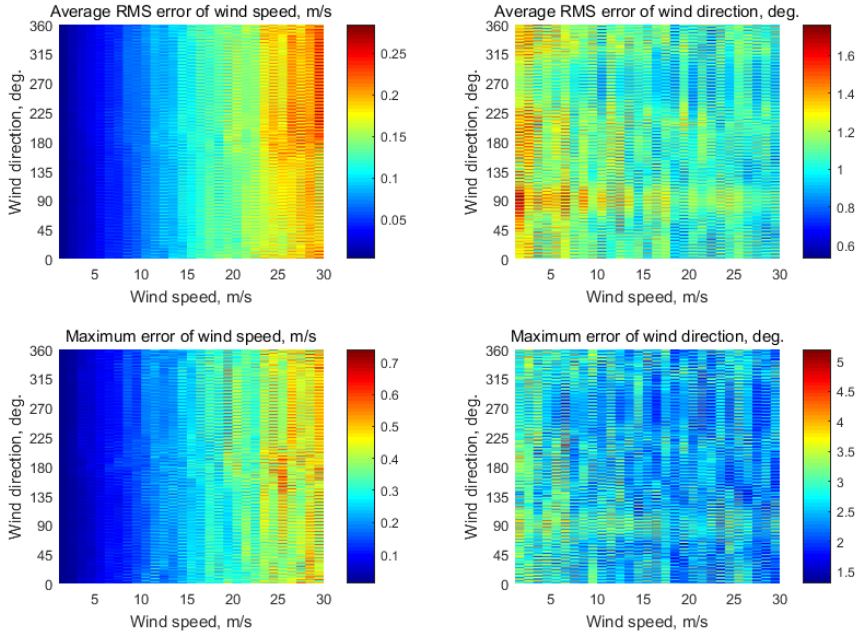
Figure A2. Semicircular wind retrieval results at a single 30° incidence angle.